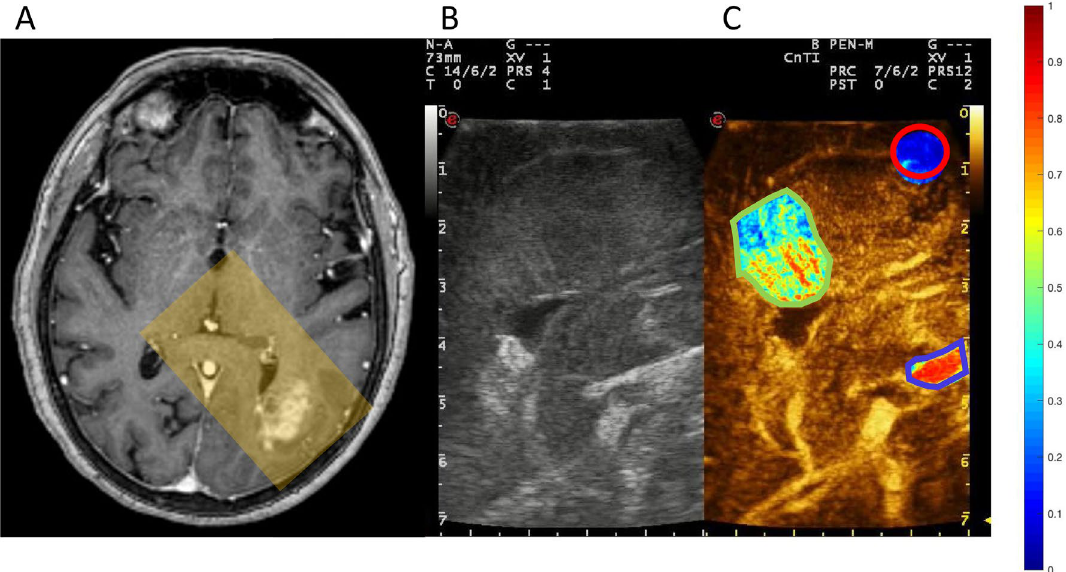
Figure 1. Qualitative view of microbubble density in selected regions in a case of parietal glioblastoma: ( A ) Gd-enhanced T1 axial MRI showing the lesion. A transparent yellow rectangle shows the plan of insonation through the craniotomy, corresponding to the US images on the right. Screenshot of the US monitor showing low mechanical index B-mode ( B ) and CEUS images ( C ). In ( C ) three ROIs are depicted, circled in blue (artery), green (tumor) and red (white matter), displaying MB density in JET colorimetric scale on the